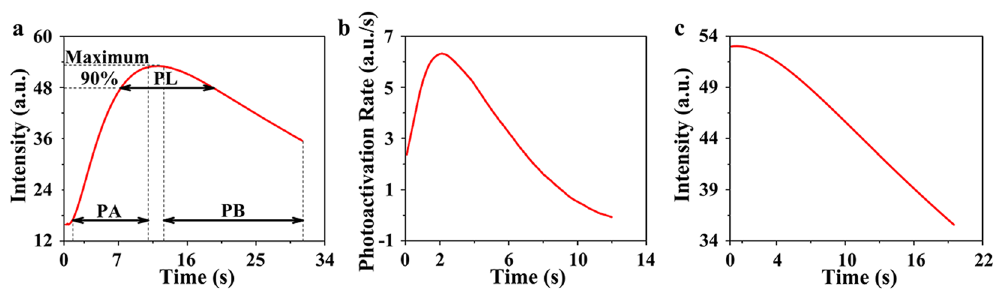
Figure 3. Fluorescence curves of the bio-QDs in cells over time. ( a ) Variation of intracellular mean fluorescence intensity that shows the processes of the photoactivation and photobleaching, and photostable lifetime; ( b ) The derivative of non-linear function of the photoactivation process reveals the photoactivation rate; ( c ) Best-fit bi-exponential form of the photobleaching curve. PA, PL and PB represent photoactivation, photostable and photobleaching process,